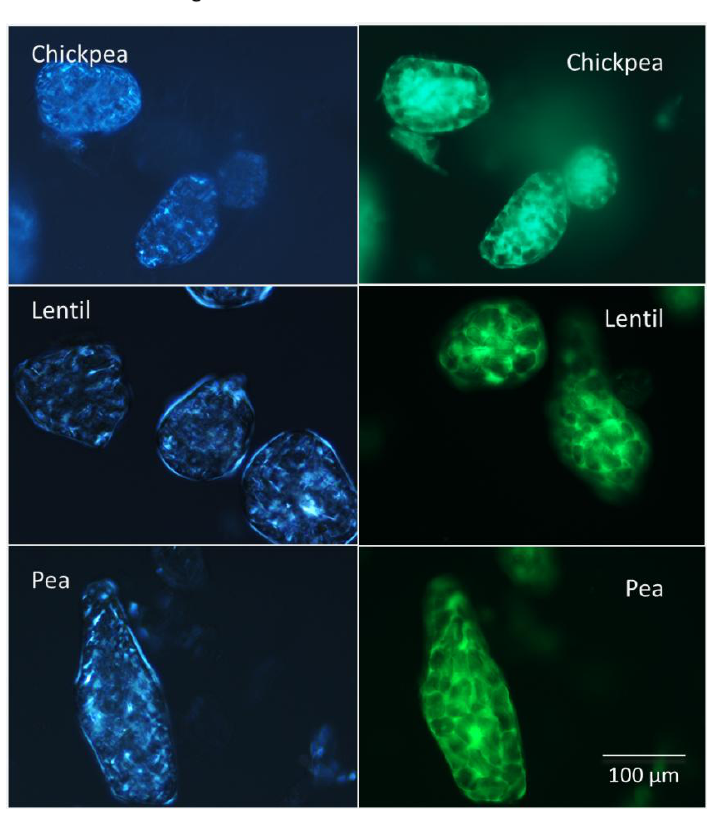
Figure 3. Polarized and autofluorescent images of spray-dried pulse powders. Under the polarized light ungelatinized starch is blue. Under light with a wave length of 470 nm cell walls fluoresce